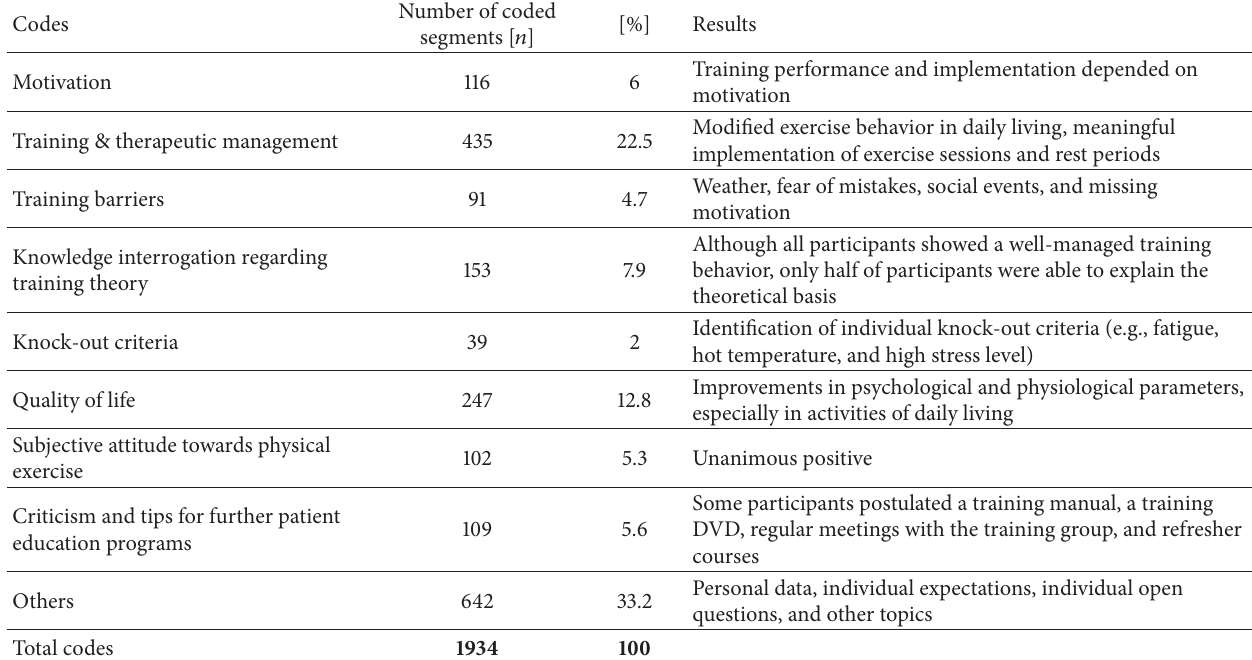
Table 7: Results of